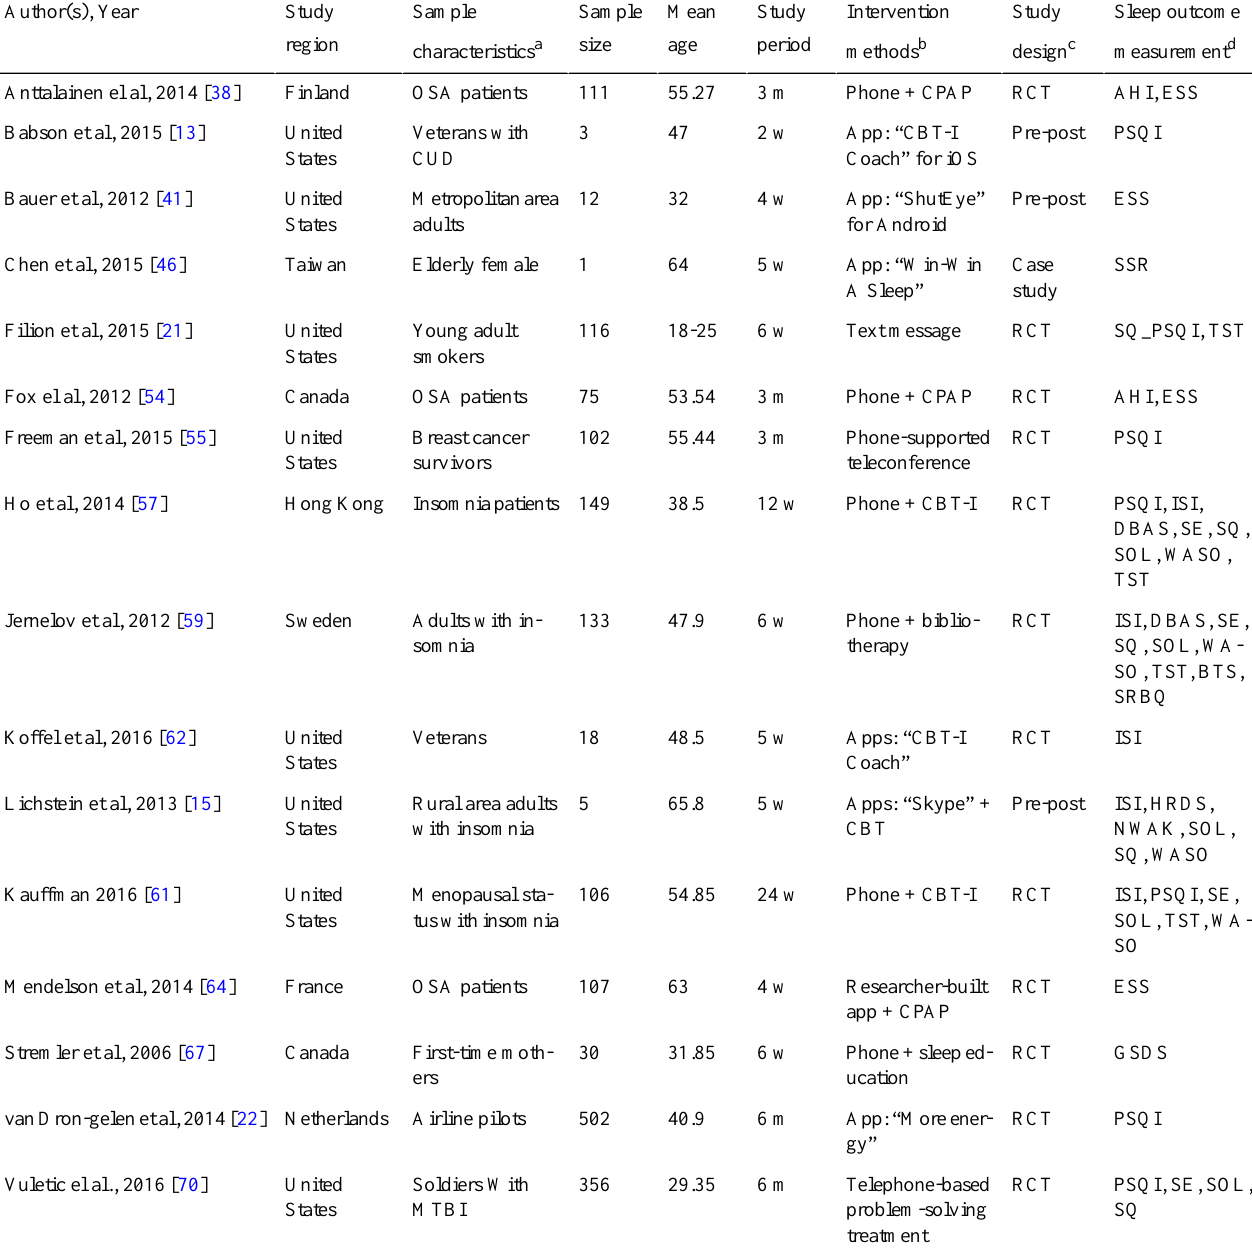
Table 1. Basic characteristics of the studies of mobile phone interventions on sleep disorders